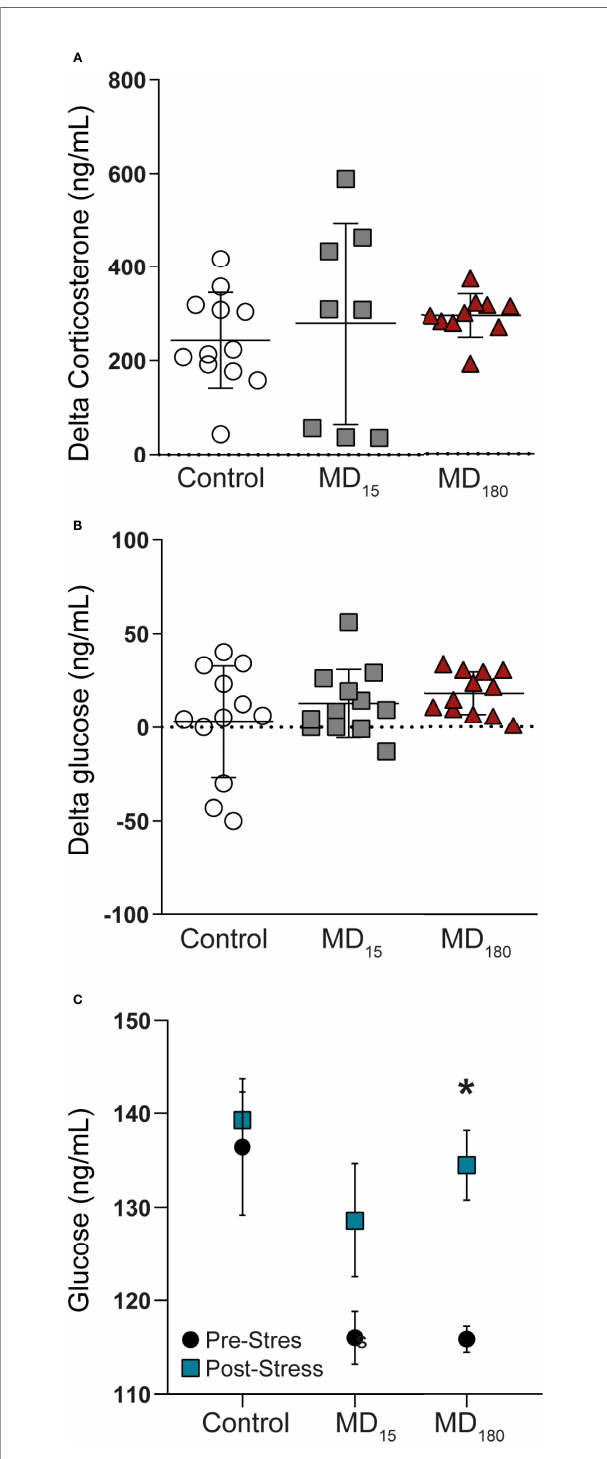
FIGURE 1 | Acute stress in adulthood has no signi fi cant impact on the HPA axis of maternal deprived animals, but changes the glucose absolute levels. (A) Delta corticosterone levels; (B) Delta glucose levels; (C) Absolute glucose levels before and after an acute stress. Data is presented as mean ± SEM of 9 to 12 animals per group. Statistics: One-way and Two-way ANOVA. *p =